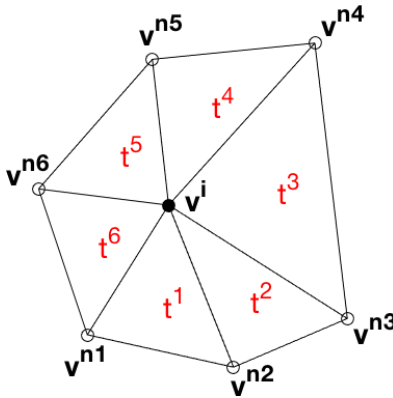
Figure A1. A very simple unstructured triangular mesh. The vertex under consideration, v i , is surrounded by its neighbours v n 1 to v n 6 , which together span triangles t 1 to t 6 . All neighbouring vertices and triangles are ordered counter-clockwise.